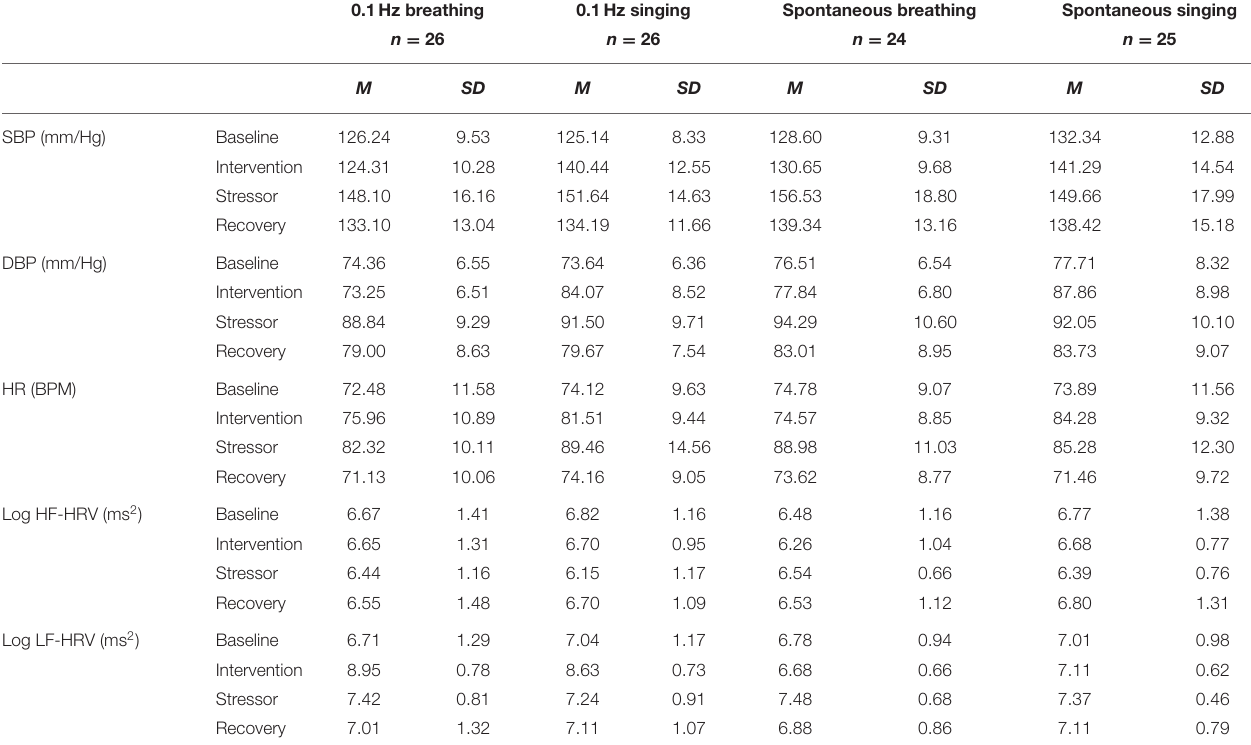
TABLE 1 | Means and standard deviation of all cardiovascular variables for the factors of experimental intervention and time. 0.1Hz breathing